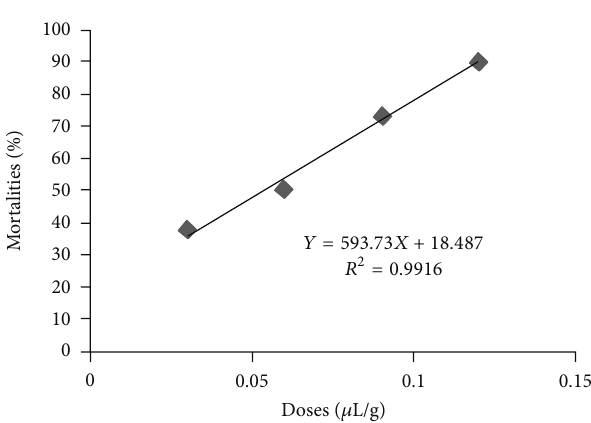
Figure 2: Evolution of mean cumulated percentages of in vitro mortality in terms of doses of the essential oils of C. ambrosoides contained in the soap.